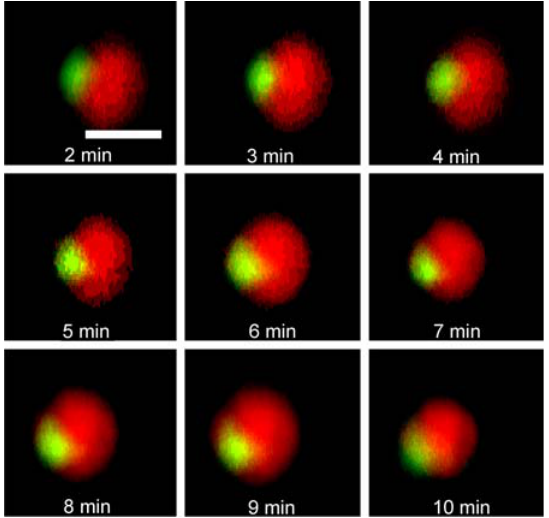
Figure 5. Reorientation of the TC-substrate contact to the GA. The GA is fluorescently labeled green and the nucleus, red. The cell sits on the horizontal, non-fluorescent TCR-binding substrate. A time-sequence of side views of three-dimensional confocal images is shown. The level of the non-fluorescent substrate under the cell is roughly indicated by the 10- m m scale bar in the first image. The GA is seen approaching the substrate on an arc. Since the TCR-binding substrate is immobile in this experimental setup, this kind of cell movement is consistent with migration of the cell-substrate contact area over the cell surface towards the eccentric GA.